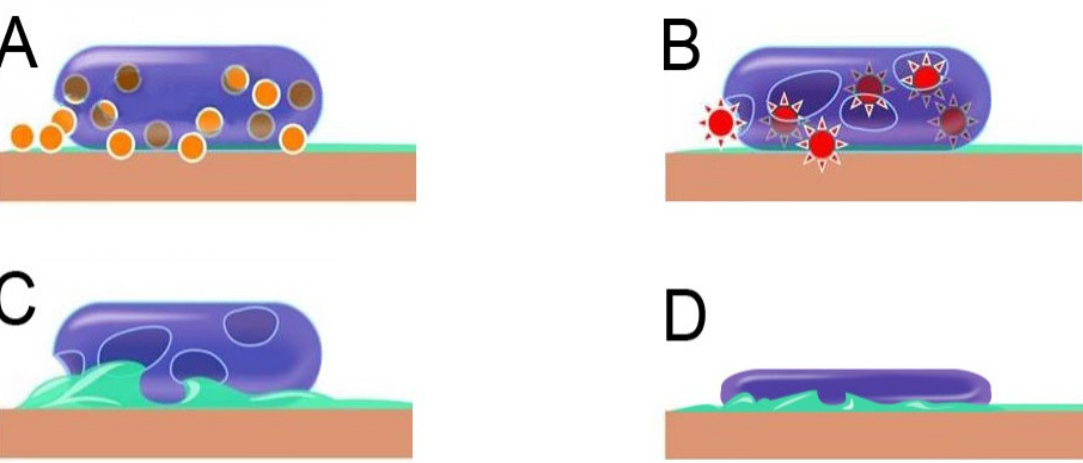
Figure 3. Artist’s view of the critical steps that are considered to be taking place in contact-killing. ( A ) When a bacterium is in touch with the copper or copper alloy surfaces, the free electrons from the copper move into the cell, probably due to the potential difference between the metal and the interior of the bacterium. ( B ) The hitting of the electron generates stress that creates holes in the bacteria’s cell membrane ( C ) When the holes become big enough, the contents in the cytoplasm come out. ( D ) The copper ions induced the generation of reactive oxygen species to cause further cell damage resulting in genomic and DNA degradation (but not in all cases) results in the death of the bacterium. In support of this, it is reported that when E. coli cells were applied on copper coupons, a large number of copper ions were taken by E. coli within 90 min, and the absorption is found to be more when the bacteria plated on the copper surface by dry method. Adapted with permission from Ref. [3]. Copyright 2007, American Society for Microbiology.